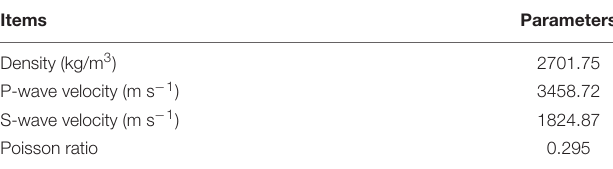
TABLE 1 | Physical properties of marble specimens.